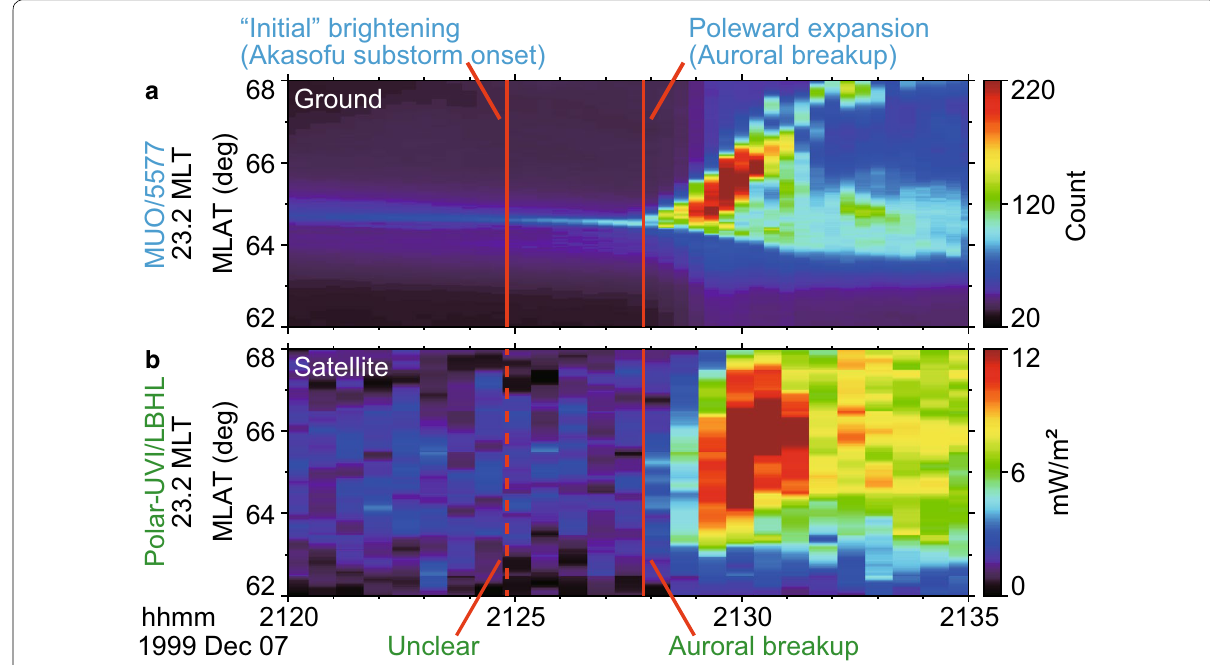
Fig. 7 Comparison of a ground-based and b satellite-based observations of auroras on December 7, 1999. The time series of full-time-resolution images were sliced along the onset meridian (23.2 MLT, 0.2 h average) and are shown as auroral keograms. The red vertical lines indicate the ± times of the Akasofu initial brightening (AIB) and the poleward expansion, which were identified in the original ground-based images. The poleward expansion (i.e., auroral breakup) at 2127:50 UT was simultaneously observed in both ASIs and GIs. The AIB was observed at 2124:50 UT in the ASIs but was not evident in the GIs against noise-level